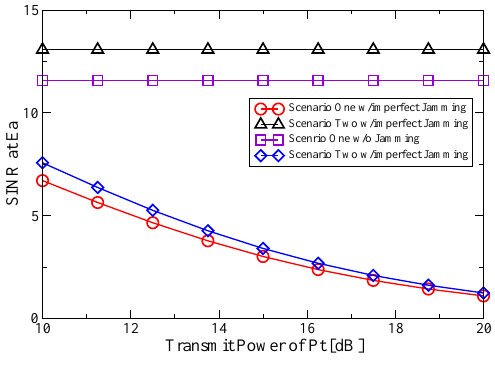
Figure 3. SINR at Ea vs. transmit power of